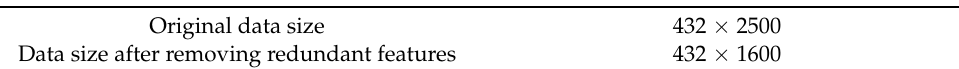
Table 2. Hypergraph Representation of Data.